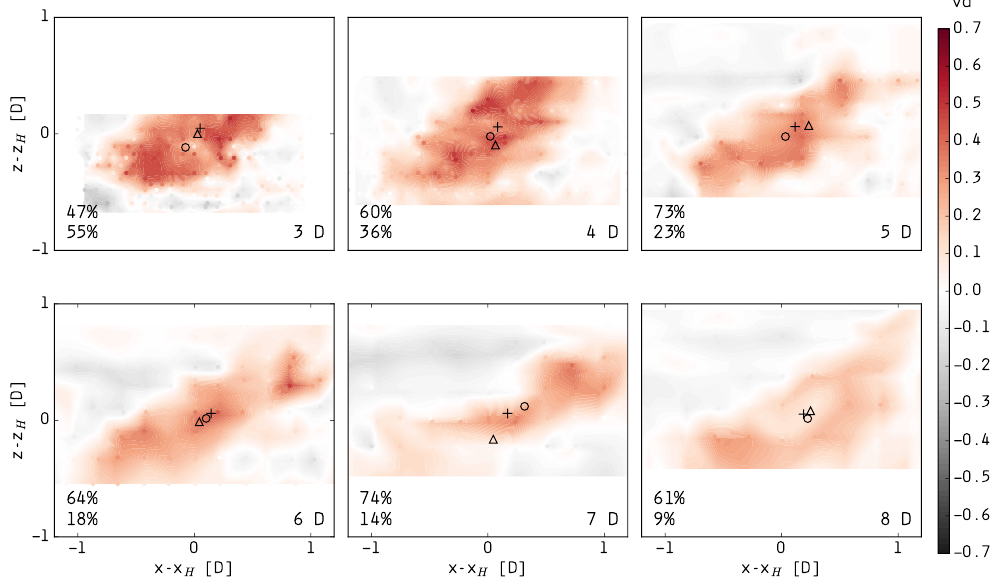
Figure 7. Velocity deficit for a synthetic 3D scan (shaded dots) and linear interpolation onto a regular grid (shaded contours) in the vertical ( z ) and cross-stream ( x ) directions at discrete distances downstream of the turbine from 3 D–8 D. Wake center from 12-min mean fields (+), from instantaneous fields at the first second of the scan ( (cid:52) ) and from synthetic scan points ( ◦ ). Free stream is estimated from downstream data. The wind direction offset for this scan is ∆ β ∼ 7 ◦ . Percent values given in each frame are SGC (top) and SGD (bottom) in (%).